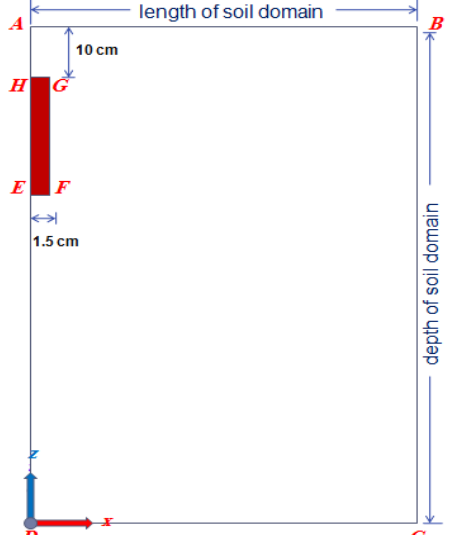
Fig. 1. A typical section of the flow medium considered for present